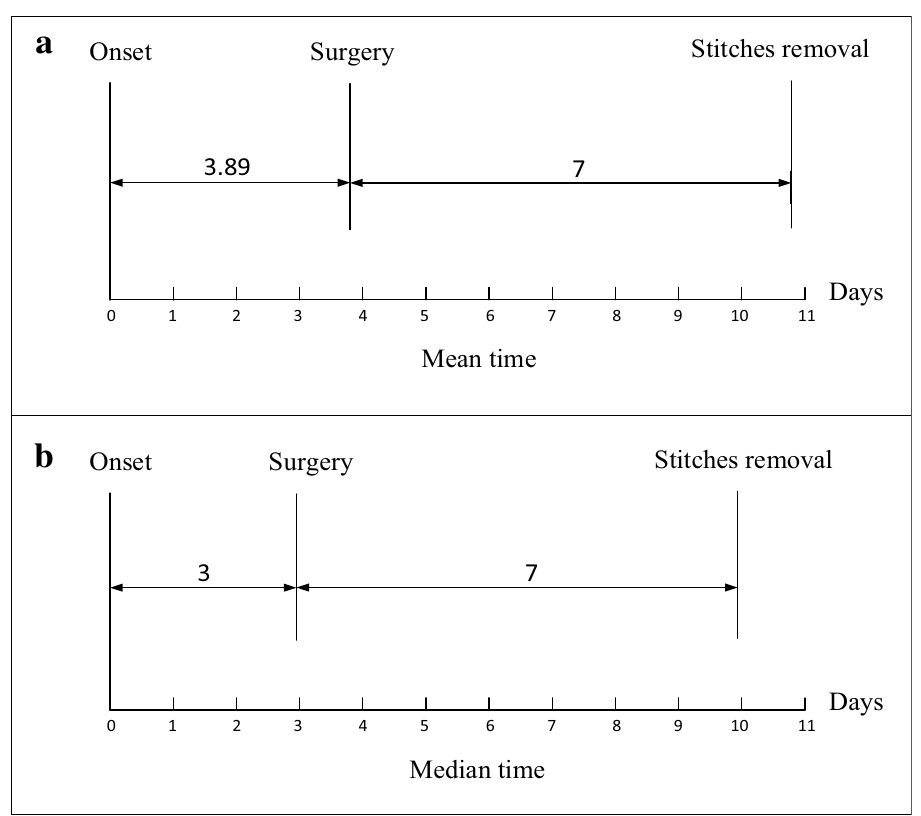
Figure 2. Timelines of “acute hemorrhagic appendicitis” after onset of